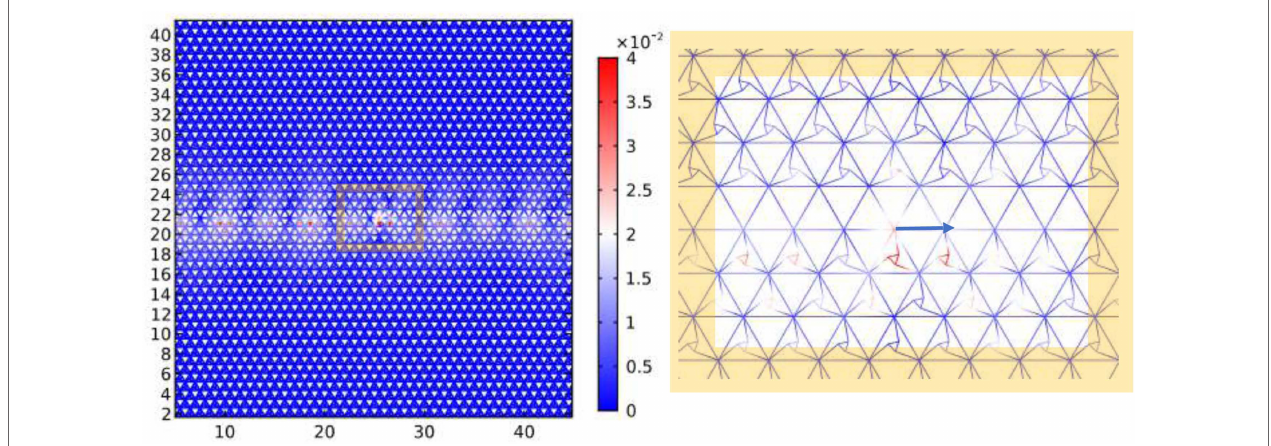
FIGURE 6 | Response of a defective triangular lattice with resonators to a harmonic point force. The defect consists of a horizontal line along which resonators are removed, as highlighted in the yellow magnified inset on the right. The point force is represented in the right inset by the blue arrow and has amplitude F = 0.1N and frequency ω = π rad/s. The parameters used in this computation are listed in the first row of Table 1 and the tilting angle is anticlockwise and clockwise, above and below the defect, respectively.